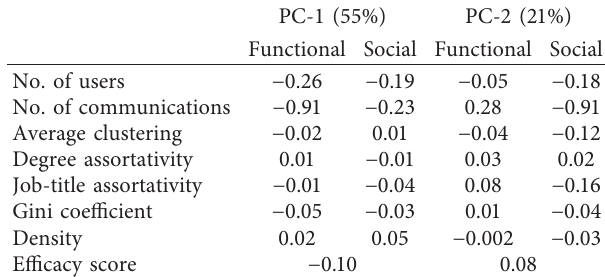
Table 3: Principal component analysis (PCA) of functional and social communication networks and efficacy score. Coefficients of each feature for the first (PC-1) and second (PC-2) components are shown. Together, the main two components explain up to 76% of the variance (explained variance by component in